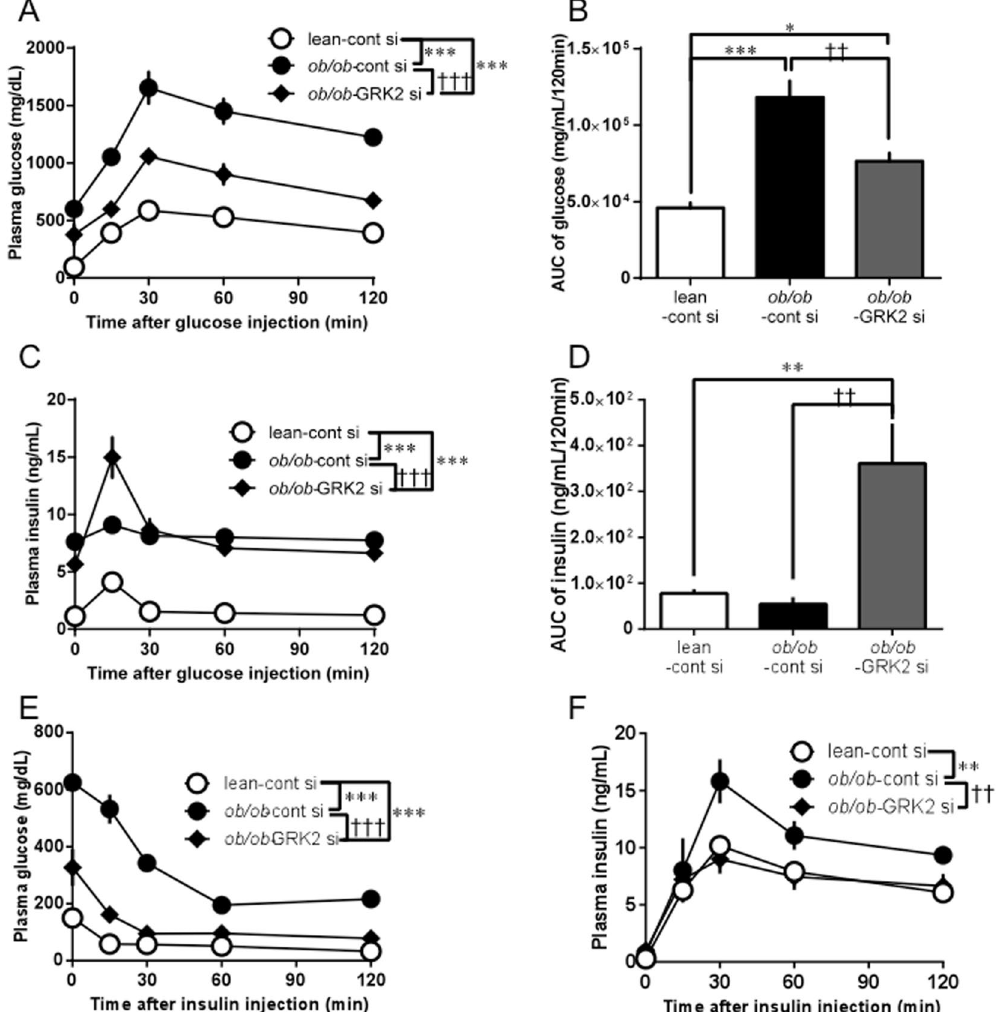
Figure 3. Suppression of hepatic GRK2 restores glucose homeostasis and insulin sensitivity in ob/ob mice. ( A–D ) Plasma levels of glucose ( A,B ) and insulin ( C,D ) were determined during a IGTT (glucose 2.0 g/kg intraperitoneally [i.p.]) performed 24 h after GRK2 siRNA injection. The AUC of glucose ( B ) and insulin ( D ). ( E,F ) Plasma levels of glucose ( E ) and insulin ( F ) were determined during an IITT (insulin 0.75 U/kg i.p.) performed after 24 h of GRK2 siRNA injection. Values are mean ± SE; n = 6. * p < 0.05, ** p < 0.01, *** p < 0.001 vs. control siRNA-transfected lean mice (lean-cont si); †† p < 0.01, ††† p < 0.001 vs. control siRNA-transfected ob/ob mice ( ob/ob -cont si) by repeated measures two-factor ANOVA test followed by Bonferroni correction for multiple comparisons ( A,C,E,F ) or one-way analysis of variance ( B,D